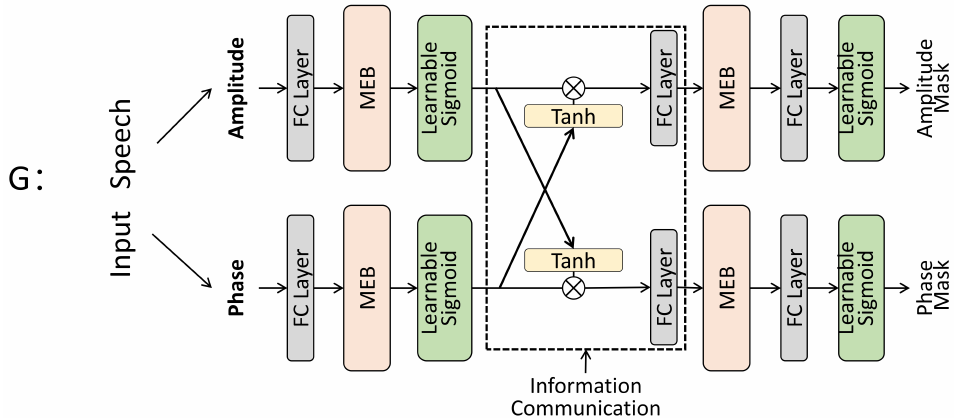
Figure 2. This is a dual stream generator structure with phase awareness. Stream A represents the amplitude stream, while stream P represents the phase stream. Streams A and P provide amplitude masks and phase masks, respectively. Each stream consists of two MEB modules.